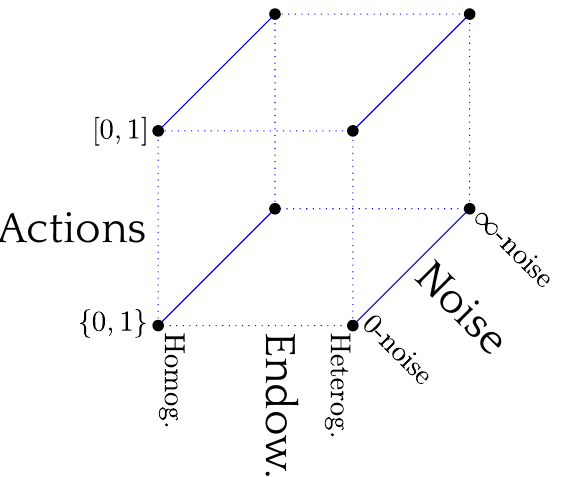
Figure 1. The figure illustrates the three dimensions that we vary to assess the robustness of the mechanism. Two are binary (indicated by the blue dotted lines): For one, players have either the same or different initial endowments; further, they either choose a proportional or an all-or-nothing contribution. One dimension is varied continuously (indicated by the blue continuous line): contributions are observed with different degrees of